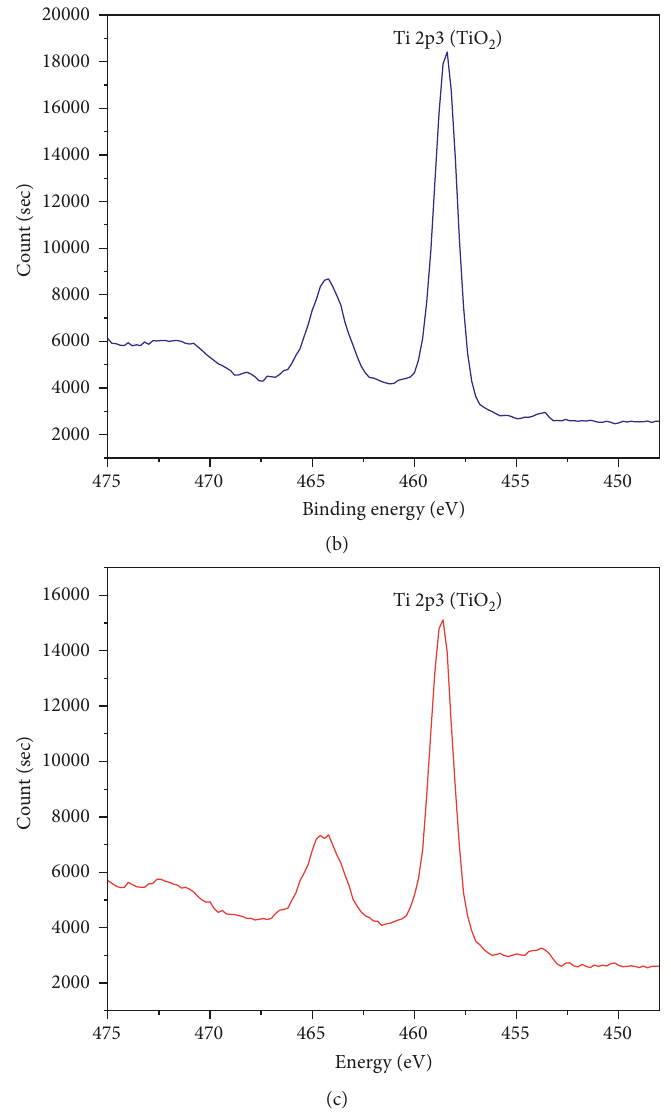
Figure 7: High-resolution XPS spectrum showing Ti 2p3/2 of (a) as-built, (b) mechanically polished (MP-1), and (c) electropolished (ER-7) Ti-6Al-4V SLM built specimens. Table 2: Ti 2p peak band energy and full-width-at-height-maximum (FWHM) of (a) as-built, (b) mechanically polished, and (c) elec-